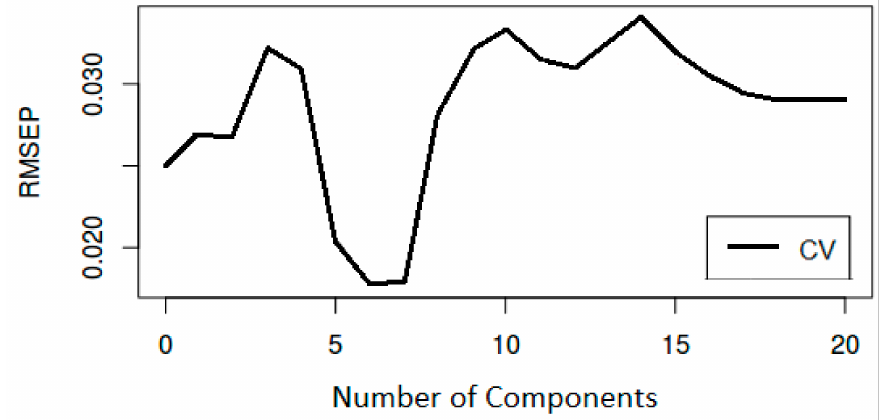
Figure 5. Validation of model performance based on number of used latent components.